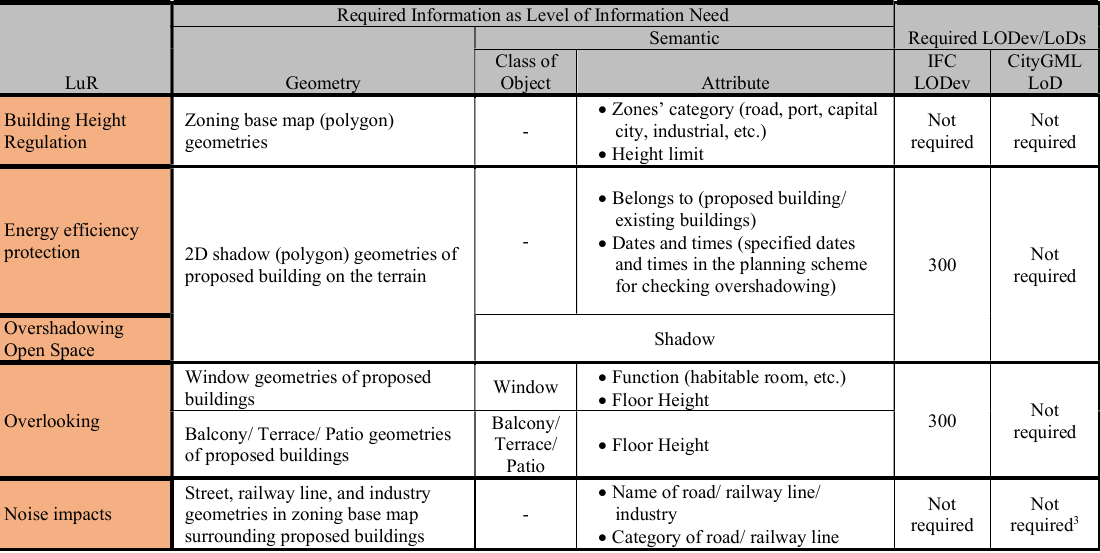
Table 6 . Required planning information and LODev/LoDs for combining 3D CityLuR with the 3D city